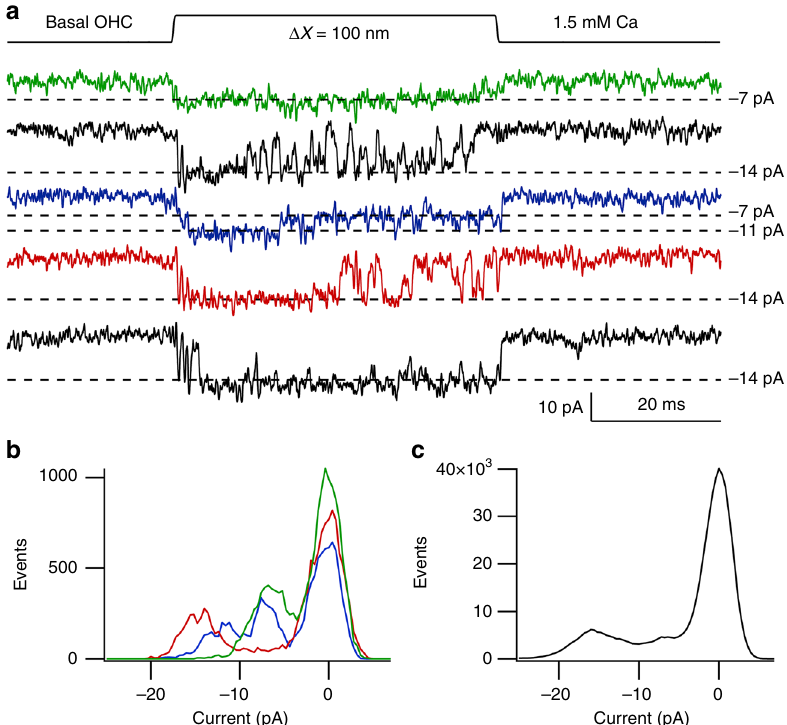
Fig. 3 Multiple single-channel levels in a basal OHC. a Five exemplar traces showing channel events during 100 nm bundle de fl ection. The principal current levels are indicated by dashed lines corresponding to − 7, − 11, and − 14 pA. b Amplitude histograms of the three colored traces showing the three levels of − 7, − 11 and − 14 pA. c Amplitude histogram of all 41 traces from this recording. The levels are smeared so it is dif fi cult to infer speci fi c levels other than the largest one. Note the smearing was not always evident (Fig. 2b). OHC from P4 Tmc2 − / − mouse; 1.5 mM external Ca 2 + ; holding potential − 84